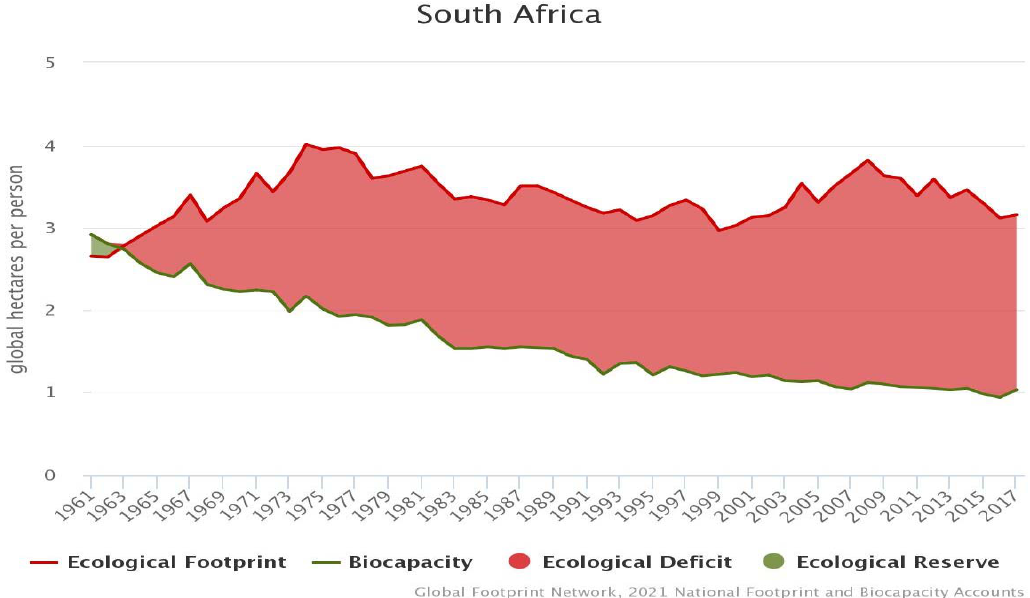
Figure 1. The trends in ecological footprint and biocapacity in South Africa.